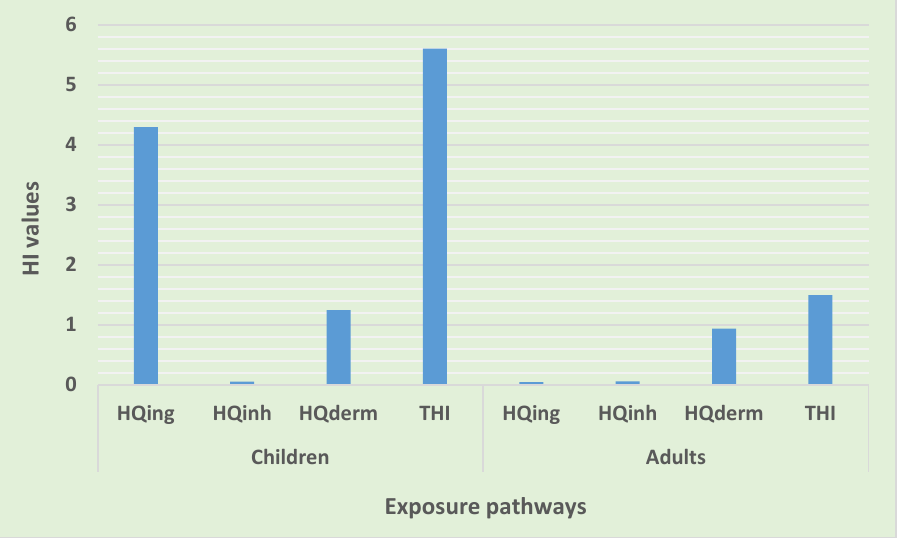
Figure 6. Hazard index for exposure to trace elements via various pathways.